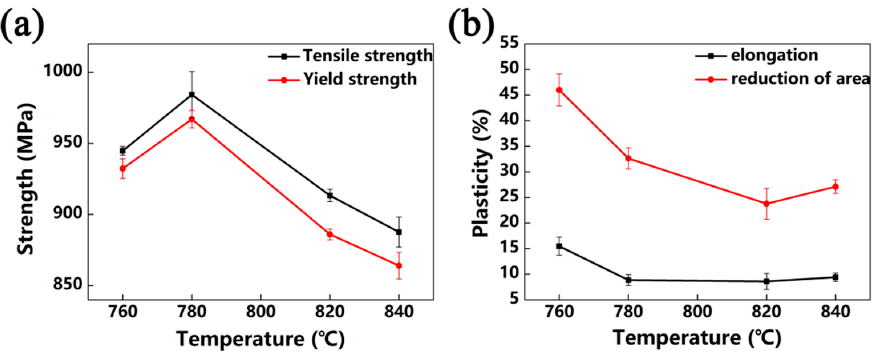
Figure 11. Tensile properties of the alloy that was solution-treated at different temperatures for 8 h: ( a ) tensile strength and yield strength of the alloy; ( b ) elongation and reduction of area of the alloy.